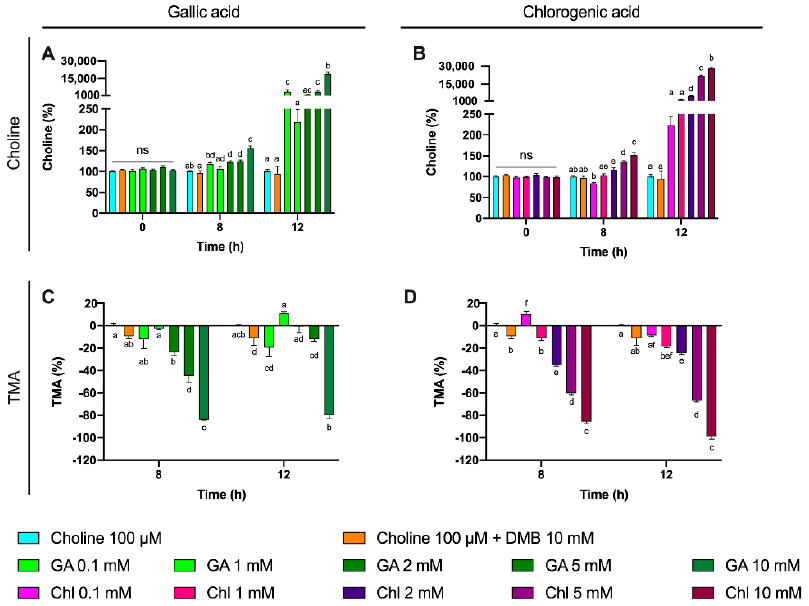
Figure 9. Gallic acid and chlorogenic acid (0–10 mM) relative choline percentage increase effect against choline-supplemented (100 µM) conditions ( A , B ). Gallic acid and chlorogenic acid (0.1–10 mM) relative TMA percentage decrease effect against choline-supplemented (100 µM) conditions ( C , D ). All fermentations were carried out at optimal conditions (fecal slurry 20% and choline 100 µM). Results are expressed as mean (%) ± SEM ( n = 6). Different letters indicate statistical differ- ences ( p < 0.05) by one-way ANOVA (Tukey’s post hoc test). Abbreviations: TMA, trimethylamine; GA, gallic acid; and Chl, chlorogenic acid.